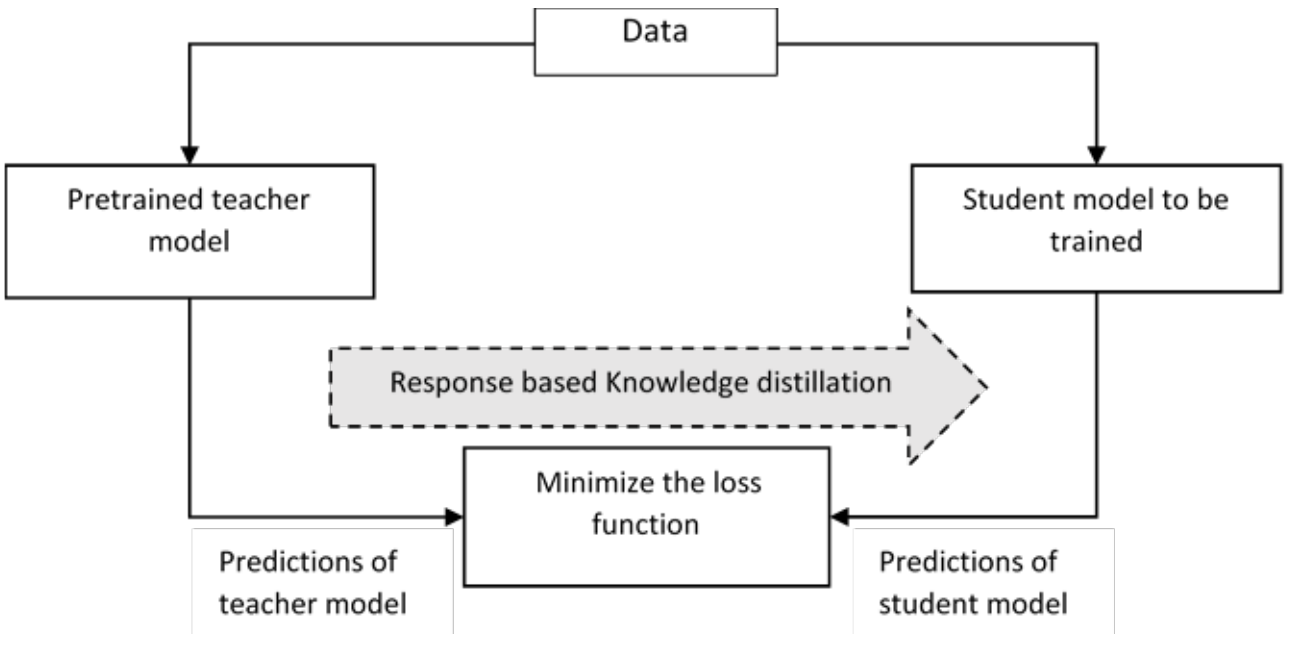
Figure 10. Knowledge distillation.